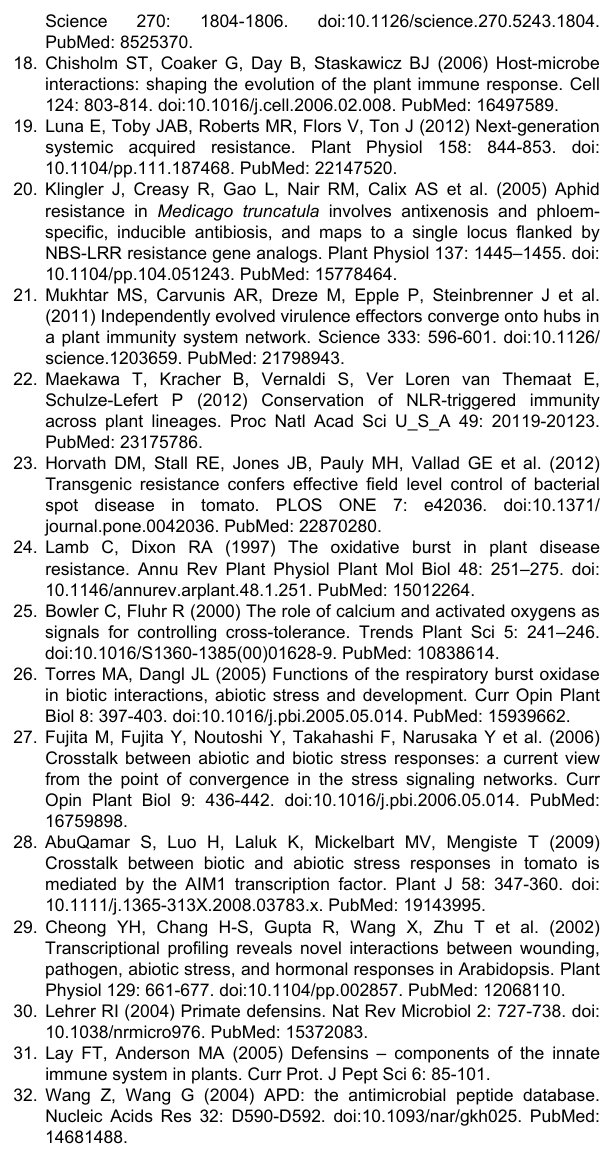
File S1. Supporting Figure and Table . Figure S1. Amino acid sequence alignment of the potato peroxidase, StPrx2 (GenBank No. AJ401150) with peroxidases from French bean peroxidase1, FBP1 (GenBank No. 149277) and pepper, CaPO (GenBank No. DQ489711). Table S1. 2 Primer sequences for gene probes.